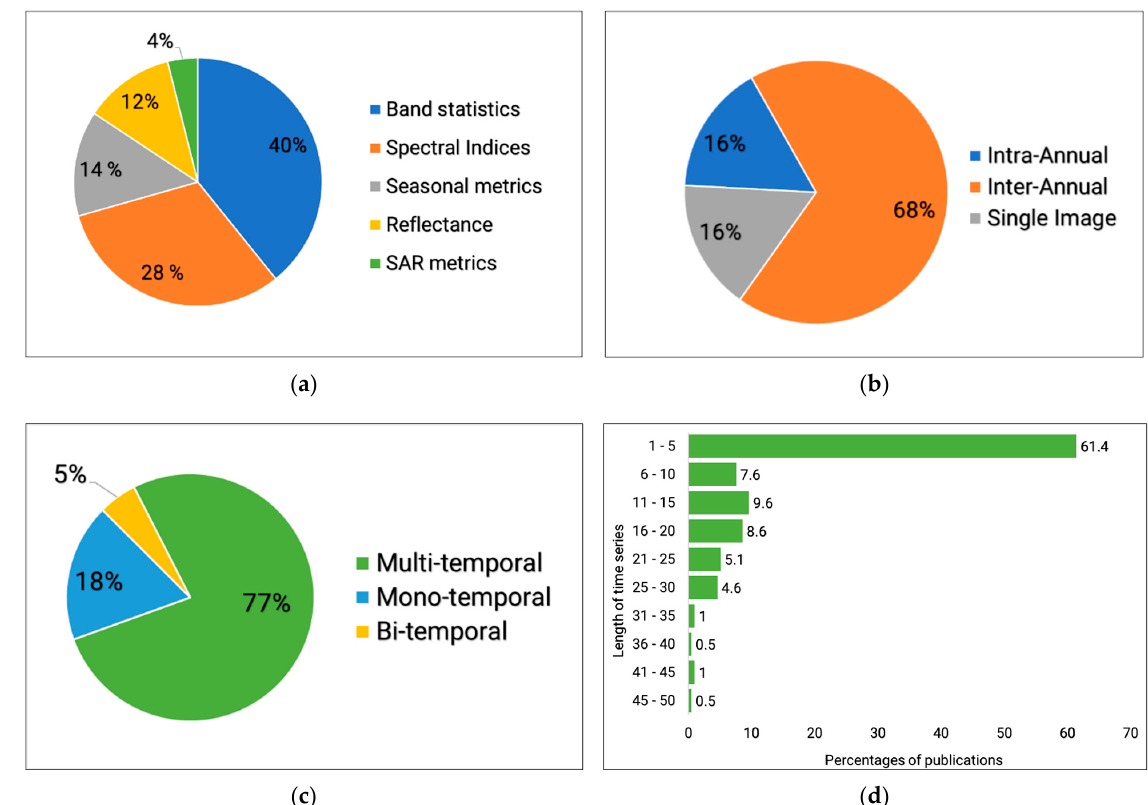
Figure 10. Overview of the type of input data properties used in the spatio-temporal mixed pixel analysis: ( a ) type of input data, ( b , c ) temporality of input data, ( d ) length of time series.